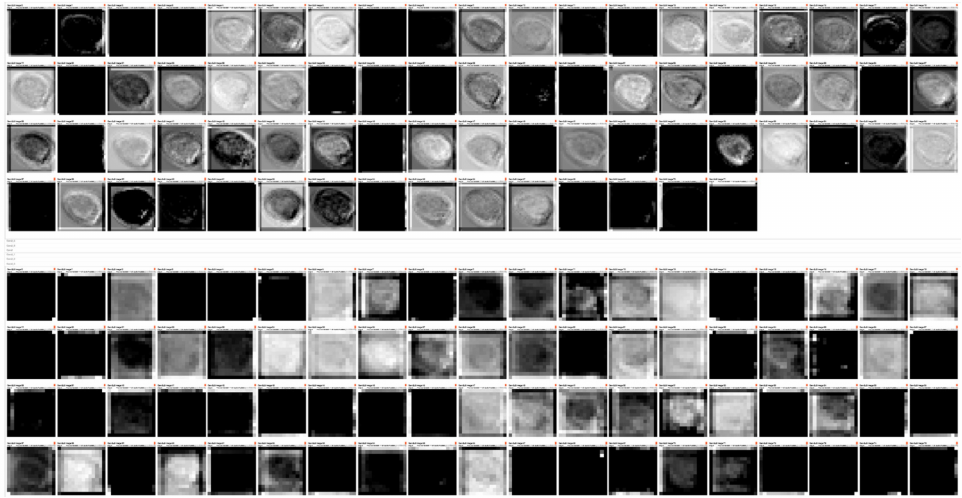
Figure 4. Convolution visualization results of AlexNet for Convolutional Layers 2 and 3. According to the results displayed in Figure 3, the AlexNet model must be